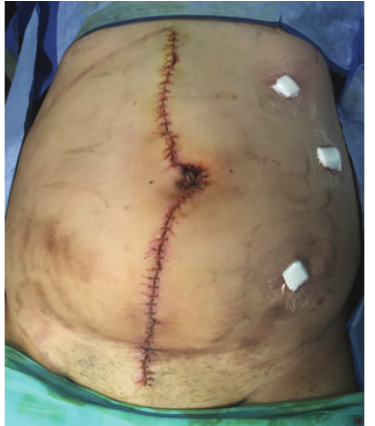
Figure 4: Postoperative view after laparoscopic